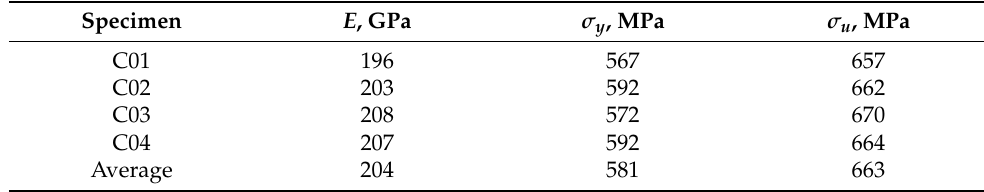
Table 1. Mechanical characteristics of axle.